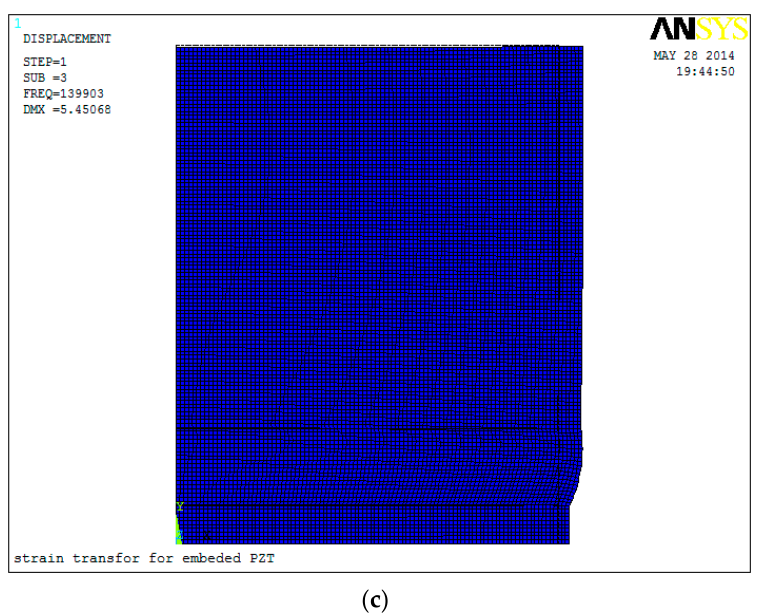
Figure 3. First three mode shapes of the embeddable PZT sensor. ( a ) The 1st modal shape; ( b ) The 2nd modal shape; and, ( c ) The 3rd modal shape. Table 1. Parameters of the PZT: waterproof layer and protecting layer. PZT Patch